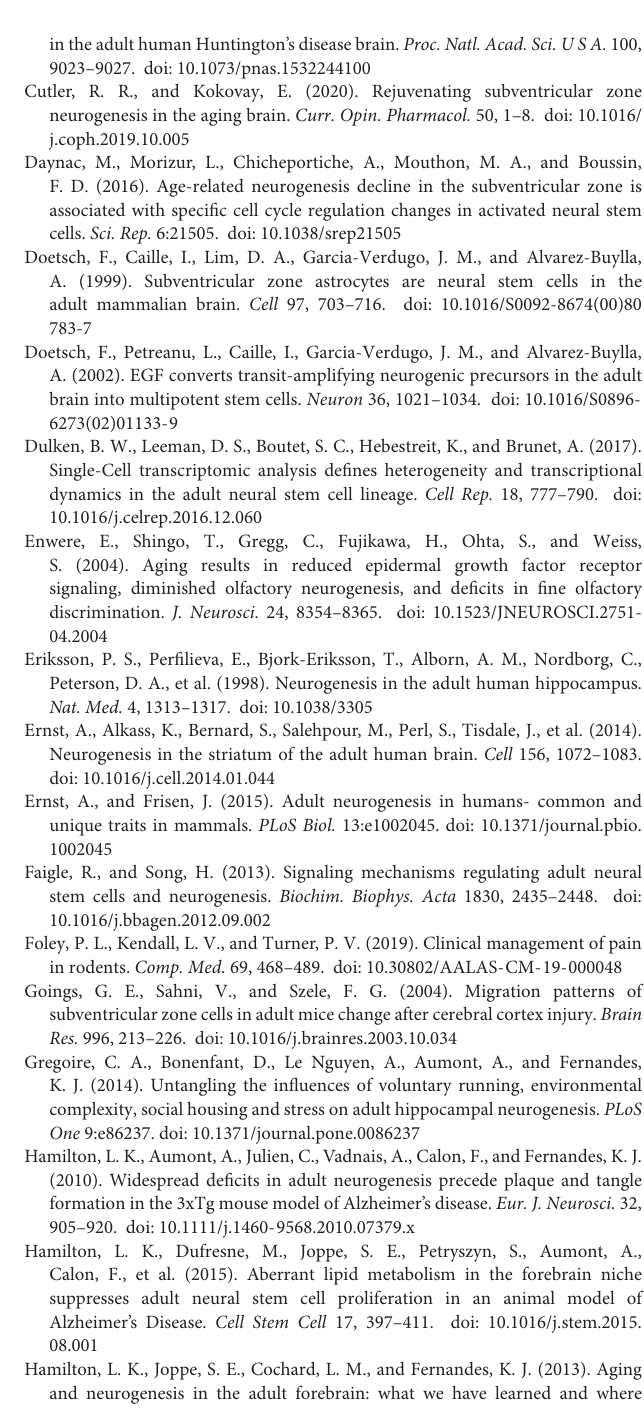
express PCNA + (actively dividing). Note that virtually all EdU + p- γ H2AX + cells are PCNA + . Scale bar represents 50 µ m in (A). Supplementary Figure 3 | (A) Schematic view of the brain slice used for SVZ and striatum microdissections. The outer rectangle represents the brain mold and the lines with arrows represent the site of sectioning with razor blades. (B) Representative micrographs of the slice obtained as seen from the rostral side (left